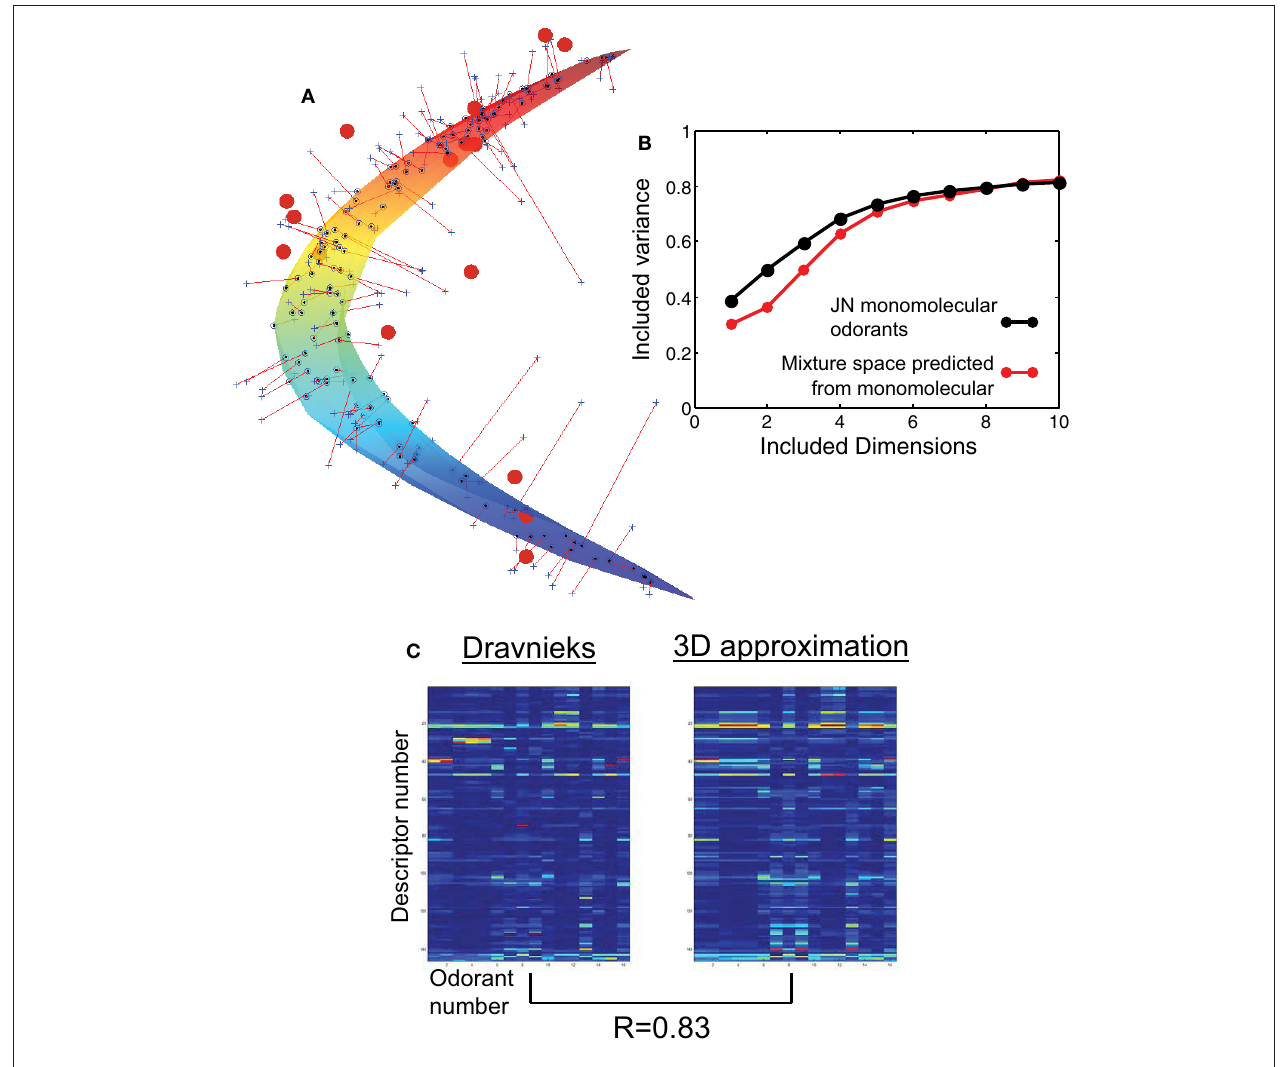
variance in the monomolecular dataset. 3D surface explains about 50% of the variance for mixtures. Therefore the 3D space obtained from monomolecular smells is as predictive of mixture data as 2D space for monomolecular data. (C) The original mixture data (left, 146 descriptors, vertical axis, by 15 mixtures, horizontal axis) and the results after projecting onto 3D monomolecular space. The point-by-point Pearson correlation is about 0.83 indicating that 3D monomolecular curved space contains major information about the responses